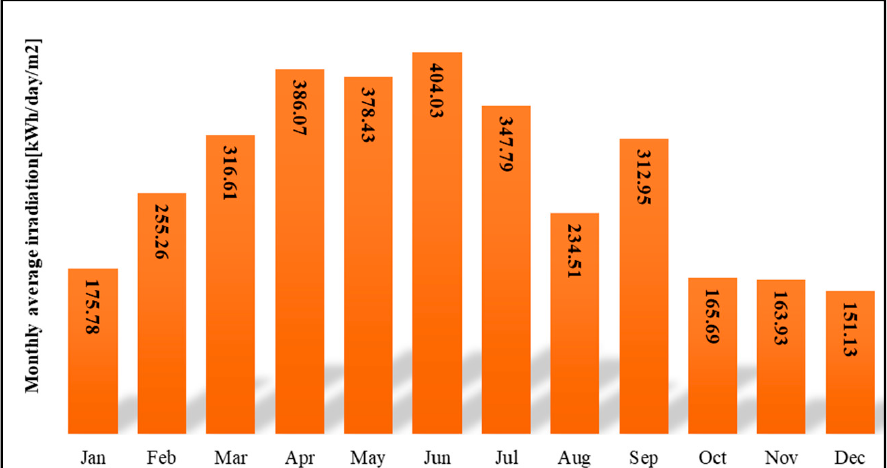
Figure 8. Monthly average solar irradiation in Fukushima.